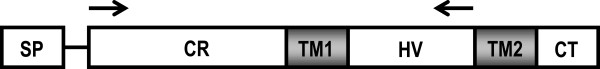
Domain architecture of the STEVOR protein family. The recombinantly expressed STEVOR used to produce the anti-PFL2610w antibody is delineated by the arrows. Abbreviations: signal peptide (SP), conserved region (CR), hypervariable region (HR), transmembrane domain (TM) and cytoplasmic tail (CT).